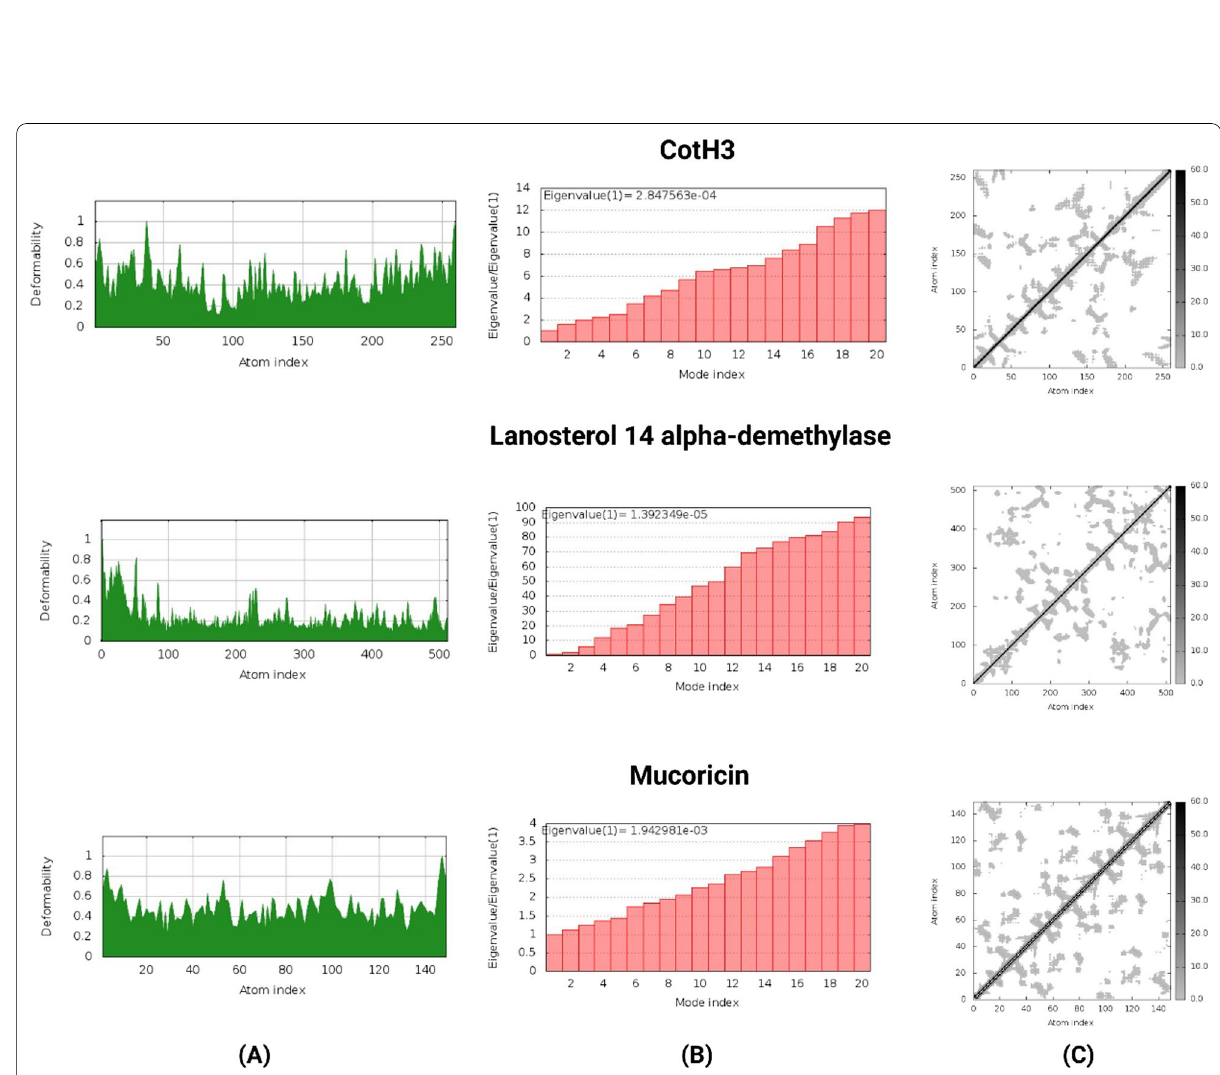
Fig. 5 Deformability ( a ), eigen value ( b ) and elastic network ( c ) of Rhizopus delemar proteins CotH3, Lanosterol 14 alpha-demethylase and